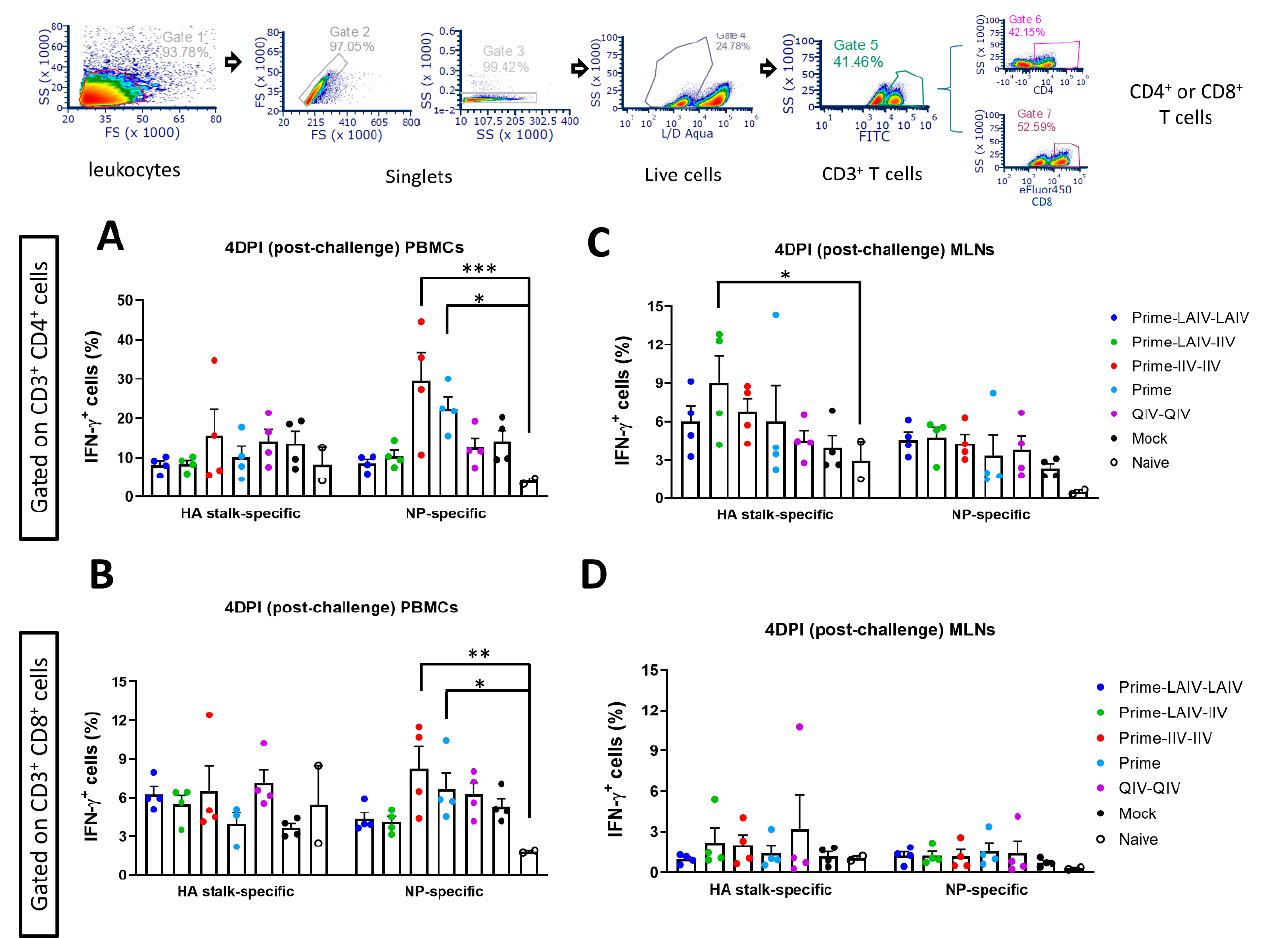
Figure 7. Flow cytometric gating scheme and analysis of influenza-specific T cell responses in peripheral blood mononuclear cells (PBMCs) and mediastinal lymph nodes (MLNs). The gating strategies for immunophenotyping of immune cells by a Gallios flow cytometer are indicated in the top panel. Singlets of lymphocytes (gated by SSC-A vs. FSC-A, followed by FSC-H vs. FSC-W and SSC-W vs. SSC-H) and live cells (based on Live/Dead Aqua stain) were acquired for analysis of T cell responses. CD3+, CD4+, and CD8+ T cells were isolated by distinct fluorescent dyes. Gated on the CD3+CD4+ cells, percentages of pH1N1 HA stalk-specific or NP-specific IFN- γ + cells in PBMCs ( A ) and MLN ( C ) were plotted, respectively. Gated on the CD3+CD8+ cells, percentages of pH1N1 HA stalk-specific or NP-specific IFN- γ + cells in PBMCs ( B ) and MLN ( D ) were plotted, respectively. LAIV-LAIV, LAIV-IIV, IIV-IIV, Prime only, and QIV-QIV vaccinated animals are shown as blue, green, red, light blue, and purple, respectively. Mock-immunized animals are shown as black. All animals except for QIV and mock groups were primed with B-cH9/1 virus. Each point indicates the percentage of IFN- γ + cells for each individual ferret ( n = 4/group). The asterisks refer to the level of significance: *: p < 0.05; **: p < 0.01; ***: p < 0.001.